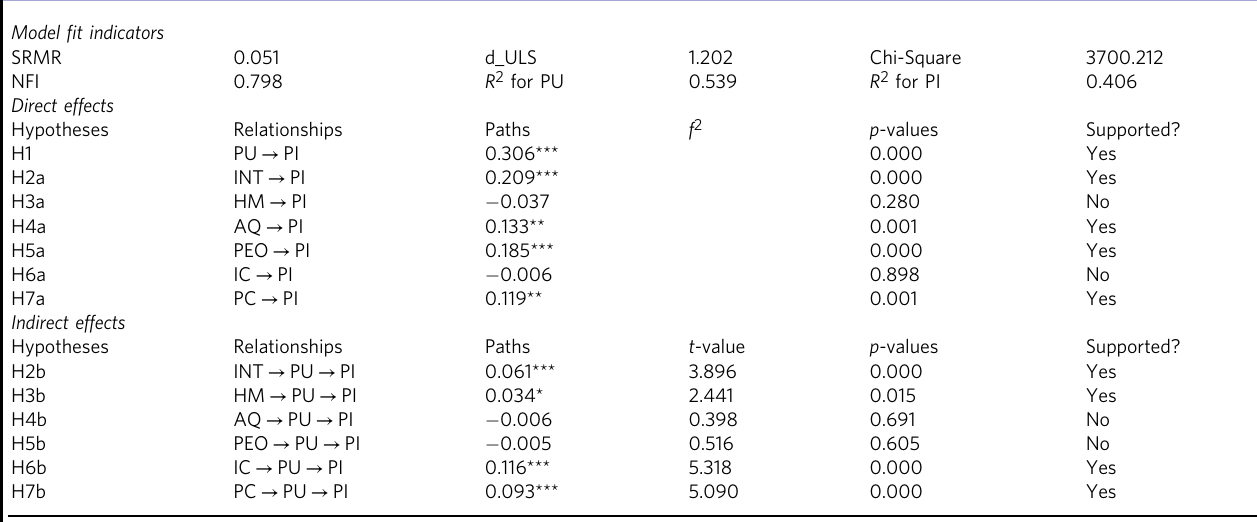
Table 3 Evaluation of the structural model.